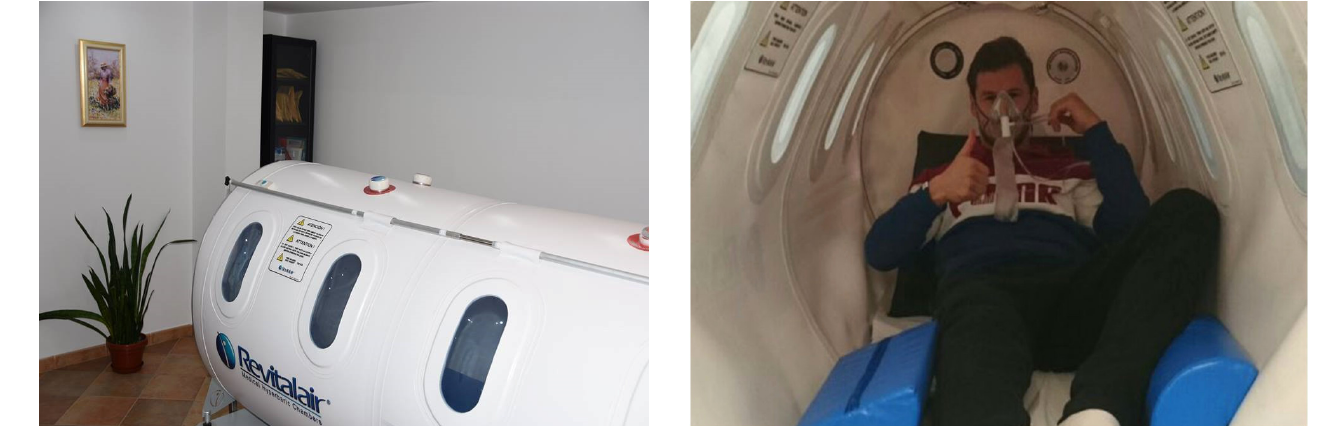
Figure 3. The monoplace hyperbaric chamber used in Biobarica Hypermed Care Clinic.